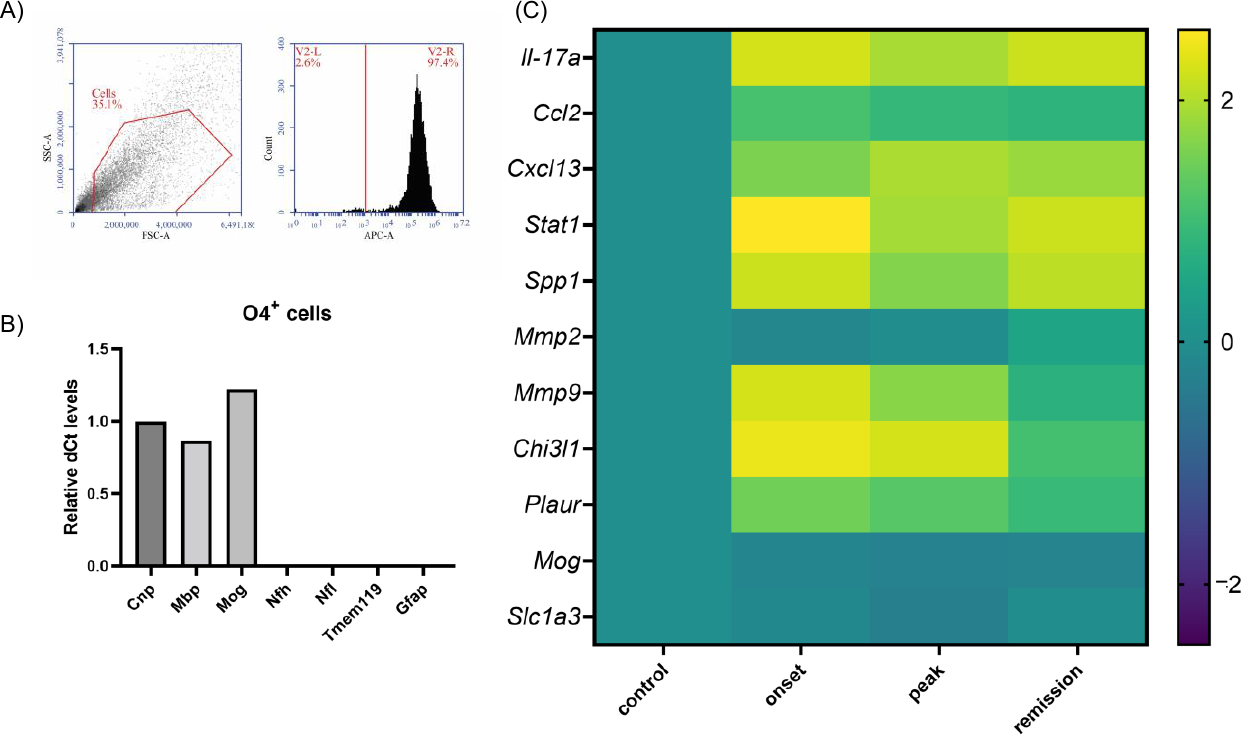
Figure 9. Validation of purity and differential expression in O4 + sorted cells during the different phases of PLP-induced EAE. ( A ) Flow cytometry analysis validating the purity of the obtained O4 cell population. ( B ) The levels of mRNA transcripts for the selected genes representative of other CNS cells were measured in O4 + cell samples isolated from naive and EAE mice on the onset, peak, and remission phases by RT-qPCR. ( C ) The levels of mRNA transcripts for the selected genes relative to Gapdh were measured in O4 + cell samples isolated from naive and EAE mice on the onset, peak, and remission phases by RT-qPCR. A total of 3 mice were used in the experiment (logarithmic scale bar).